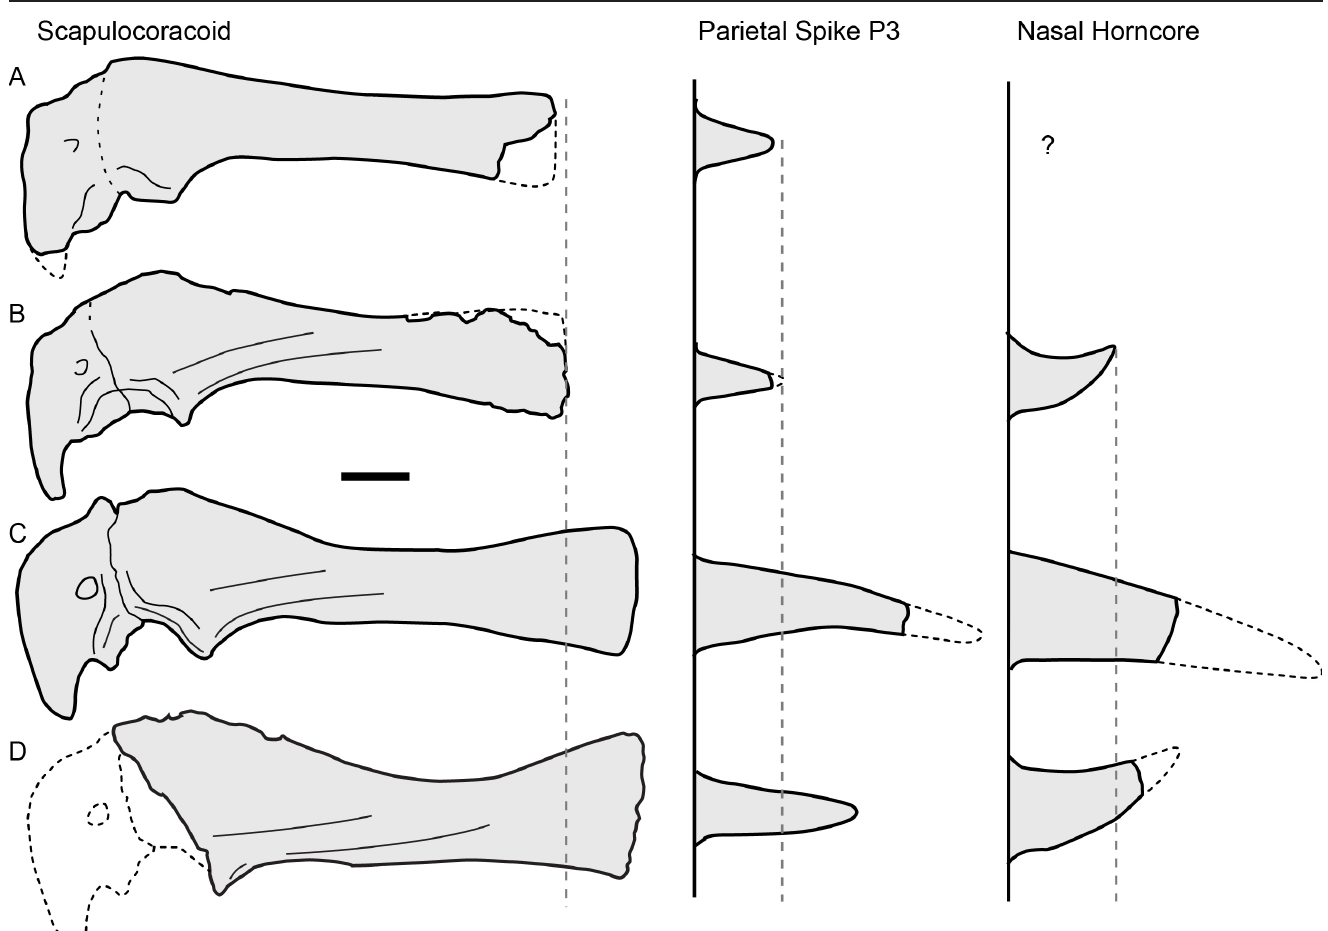
Figure 9. Absolute size comparison between the scapulocoracoid in lateral view (left column), parietal spike P3 in dor- sal view (central column), and nasal horncore in left lateral view (right column) for four Styracosaurus specimens. A, TMP 1989.097.0001 (subadult). B, TMP 2009.080.0001 (subadult). C, CMN 344 (adult). D, UALVP 55900 (adult). All elements scaled to the same size. Scale bar = 10